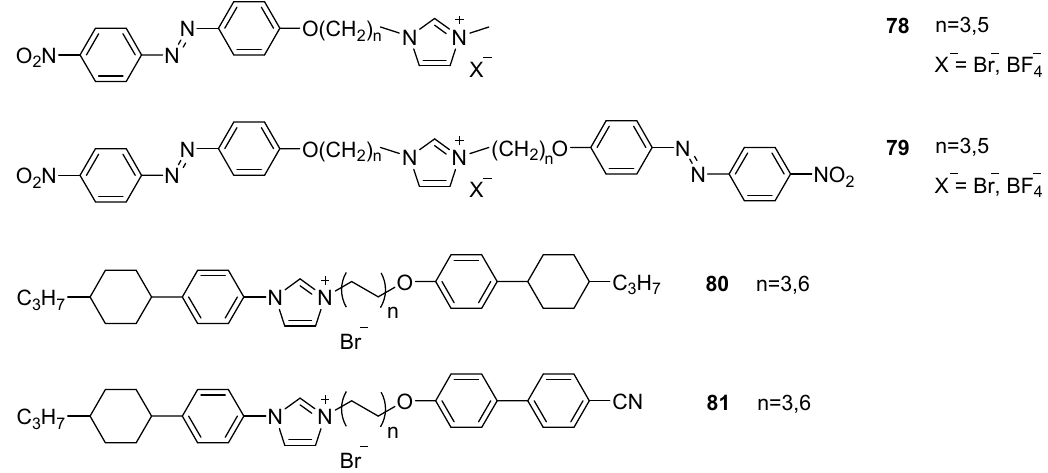
Figure 19. Imidazolium-based ILCs with light-sensitive azobenzene mesogen-like moieties ( 78 , 79 ) and hybrids with a rigid-core structure that is substituted at the second heteroatom position by a mesogenic group, connected through a medium or long spacer ( 80 , 81 ). Compound 81 exhibits the rarely observed enantiotropic nematic phase at, even at room temperature as would be an excellent lead for further exploration into applicable ILC materials.